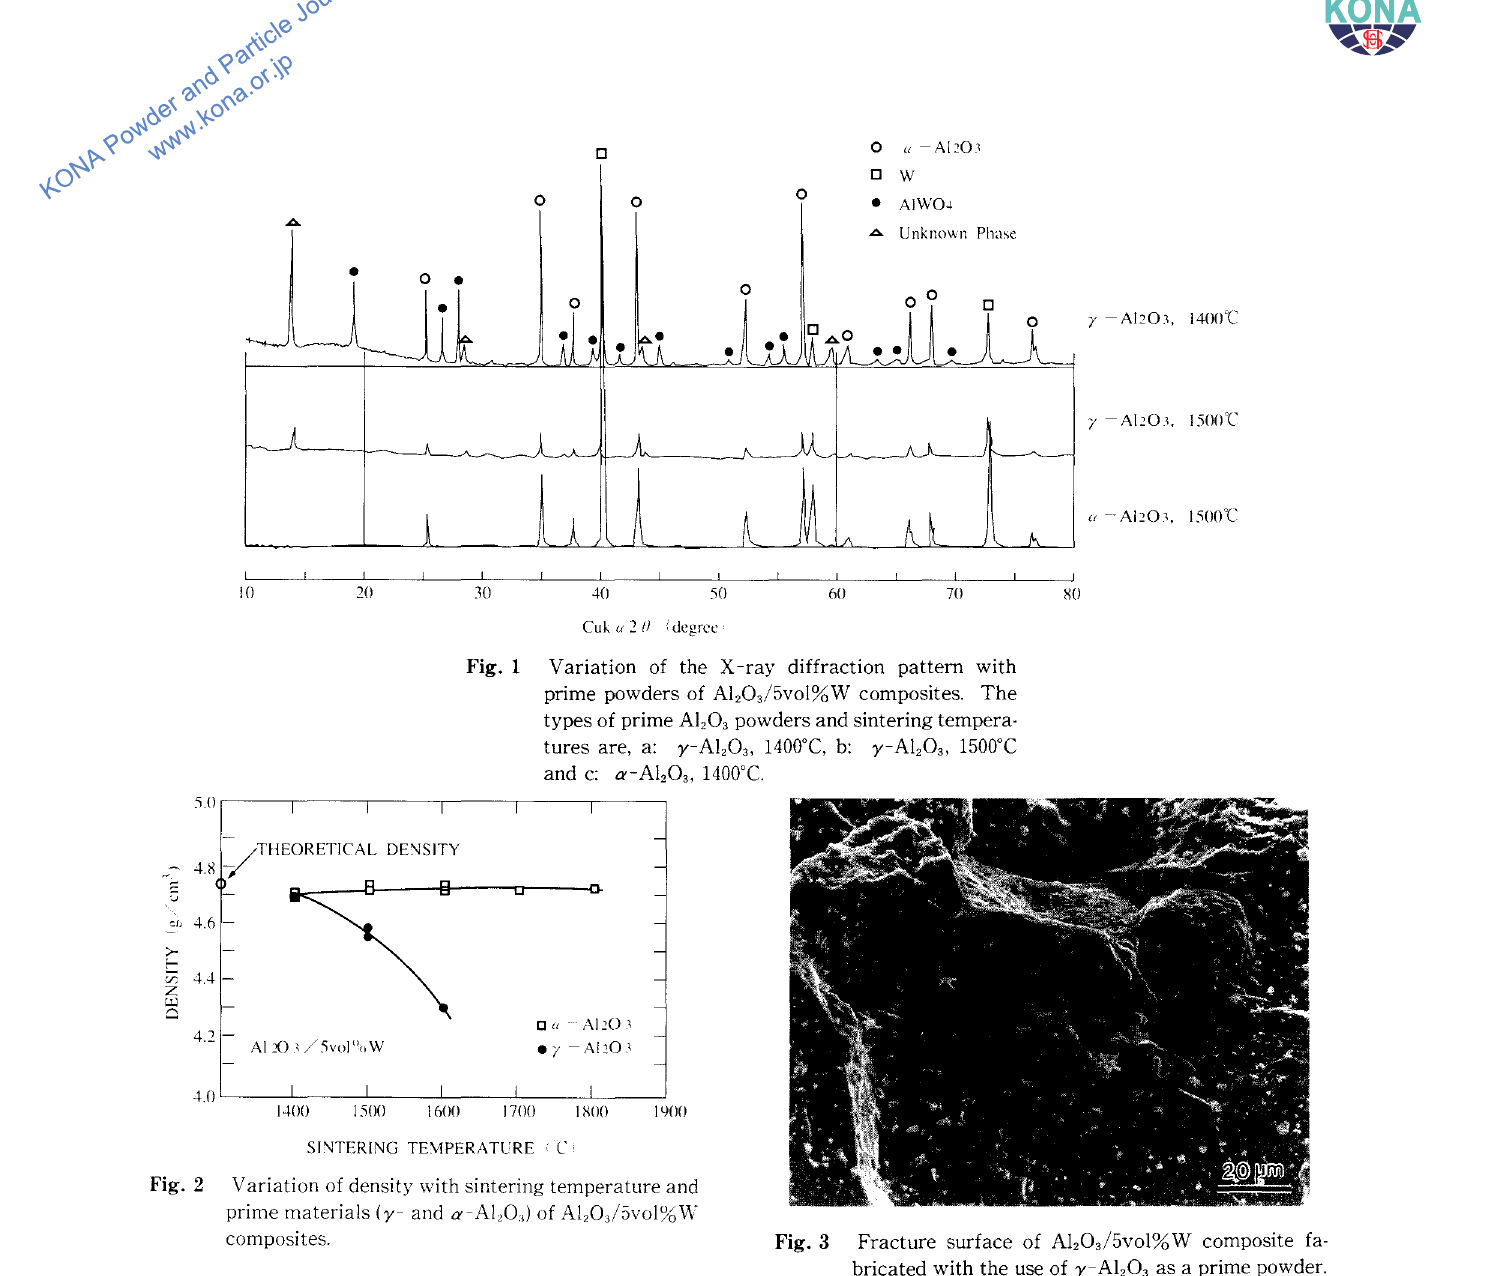
0 /5vol%W composite fa 2 3 bricated with the use of y-Al,0 as a prime 3